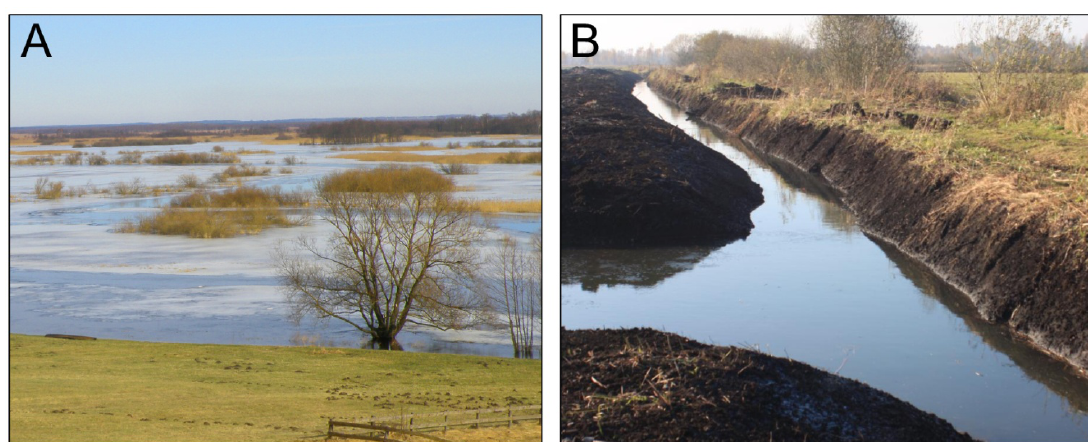
Figure 1. ( A ) Natural floodplain wetlands in the Lower Biebrza Basin; ( B ) Freshly (2011) trained river Klimaszewnica—a tributary of the Biebrza in the Lower Biebrza